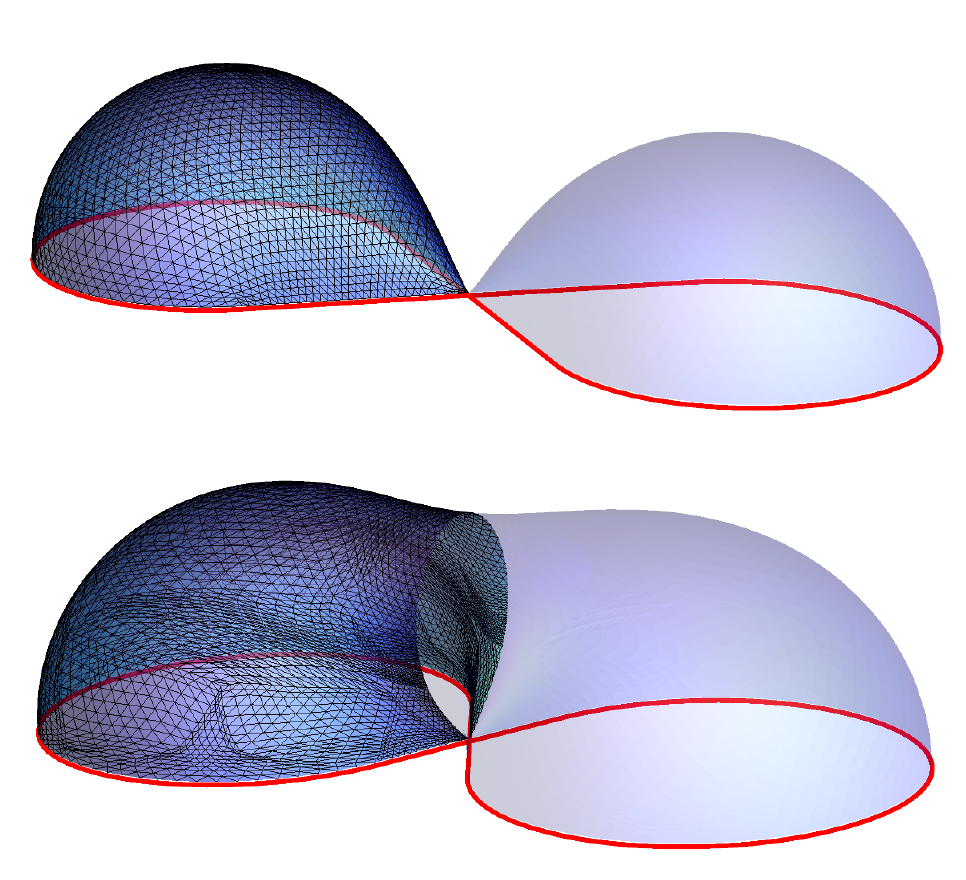
Figure 5 . Triangulated surfaces in H 3 approximating the minimal area surfaces ^ (cid:13) A which corre- spond to two di(cid:11)erent double drop regions A described in section 3.2. For these domains (cid:30) 1 = (cid:30) 2 (cid:17)